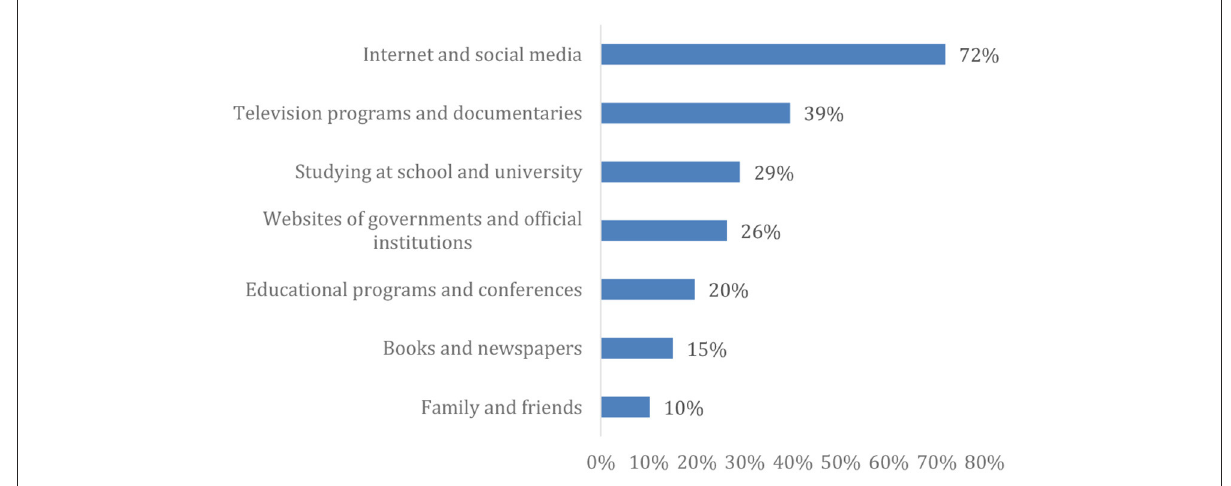
FIGURE3 Percent distribution of the enrolled participants by source of